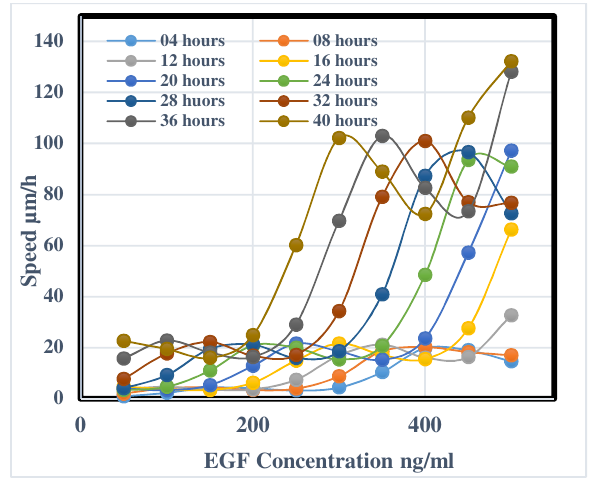
Fig. 8. Speed of healing to the EGF concentration for 10 steps of